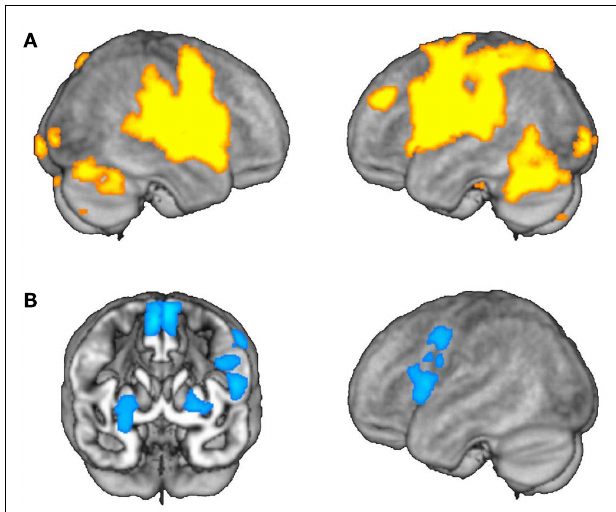
FIGURE 2 |Average effects of activation and adaptation. (A) Areas showing average effects of task-related activation, irrespective of grammatical category. (B) Areas showing average effects of adaptation, irrespective of grammatical category.